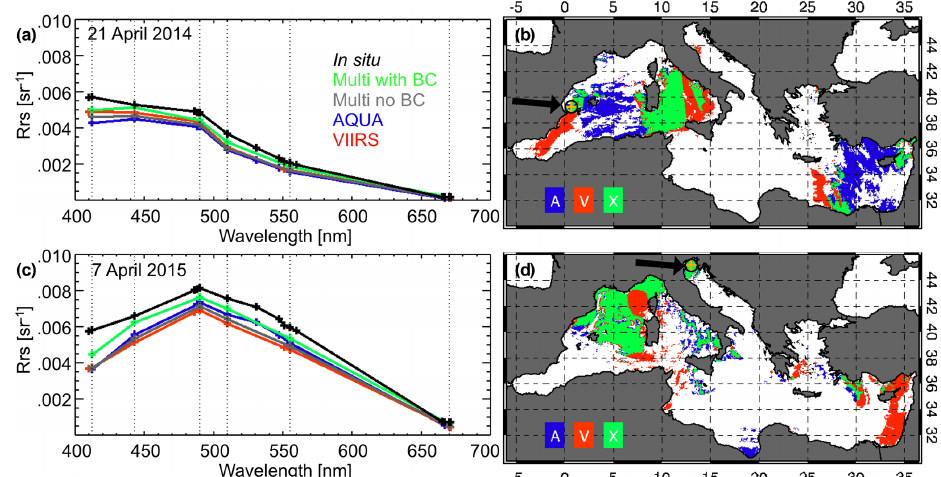
Figure 5. Rrs spectra from 21 April 2014 (a) from MODIS Aqua (A, blue), NPP-VIIRS (V, red), the merged multi-sensor product with the application of the bias correction (X, green) and without (grey), and the in situ measurements (black), all in correspondence to the in situ measurement location shown by the arrow in panel (b) . The map in panel (b) is the sensor mask of the day on which the pixels sampled by MODIS Aqua only are shown in blue and those by NPP-VIIRS only in red; the pixels sampled by both sensors are shown in green. Panels (c) and (d) refer to the Rrs spectra and sensor mask from 7 April 2015, in the northern Adriatic